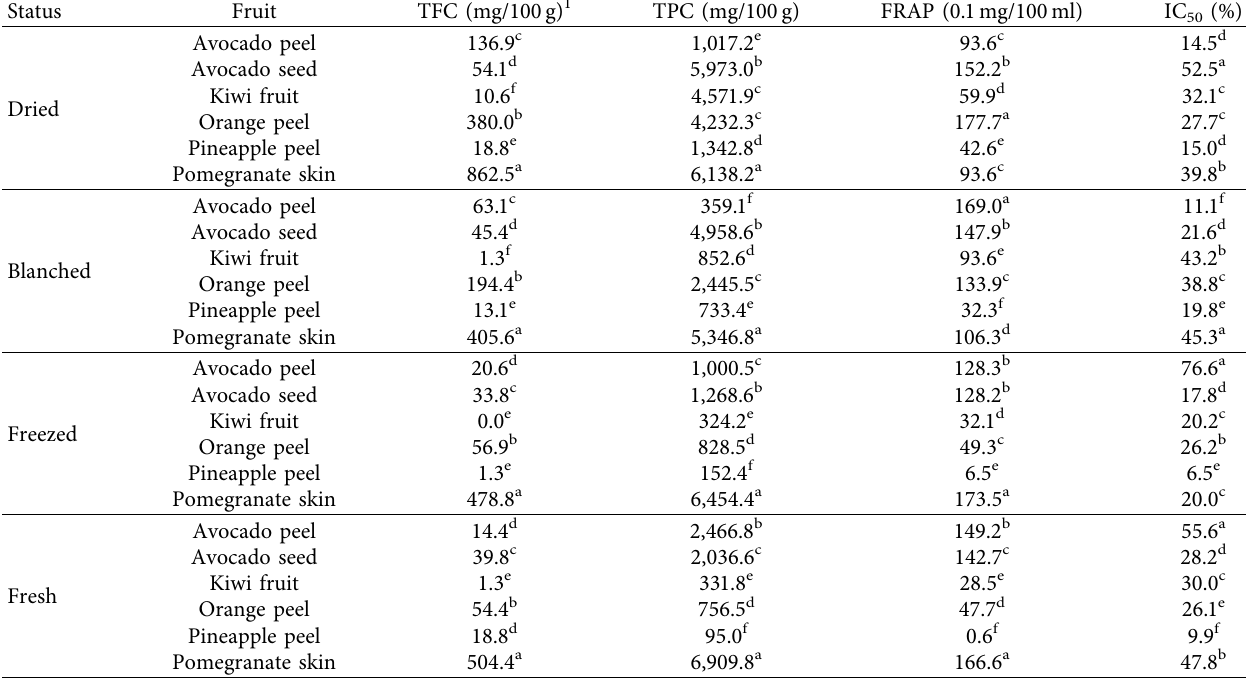
Table 2: Average flavonoid content (mg/100 g), phenolic content (mg/100 g), reducing power (0.1 g/100ml), and DPPH inhibition (%) of dried, blanched, freezed, and fresh avocado peel, avocado seeds, kiwi fruit, orange peel, pineapple peel, and pomegranate